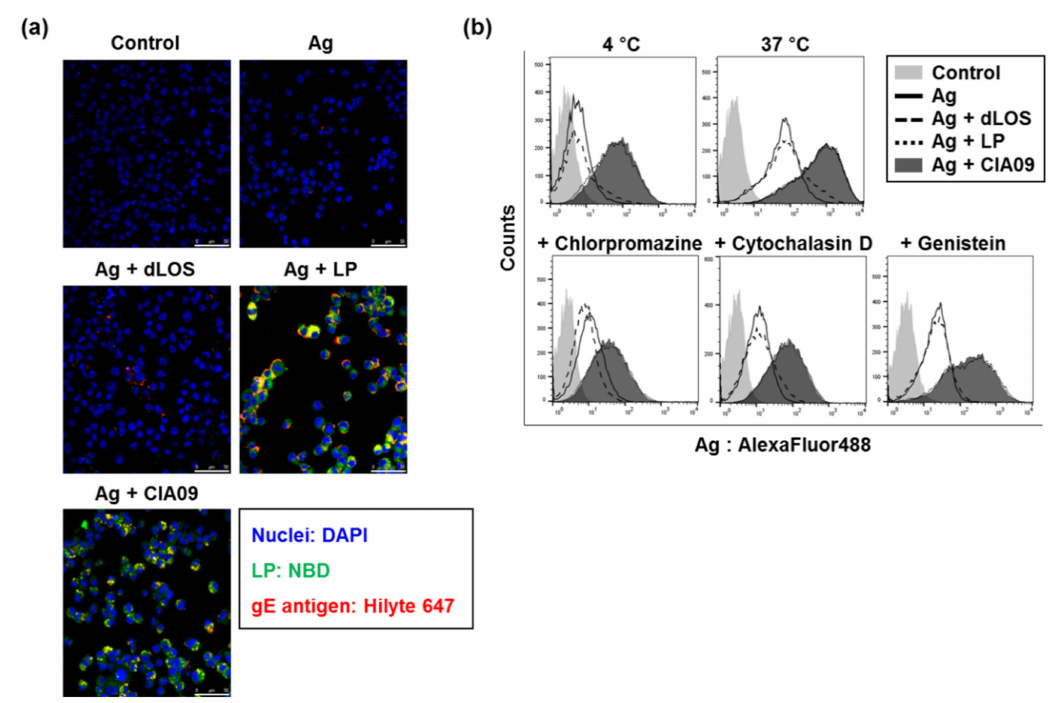
Figure 4. Liposome-mediated antigen uptake by DC2.4 cells. ( a ) Cells were incubated with Hilyte 647-labeled VZV gE antigen alone or gE plus dLOS (3 µ g/mL), NBD-labeled liposomes (LP) (100 µ g/mL), or both (CIA09) at 37 ◦ C for 4 h, stained with DAPI, and imaged by confocal microscopy. Scale bars = 50 µ m. ( b ) Cells were incubated with AF488-labeled gE antigen alone or gE plus dLOS (3 µ g/mL), liposomes (100 µ g/mL), or CIA09 at 4 ◦ C or 37 ◦ C for 2 h and analyzed by flow cytometry. Endocytosis inhibitors were added to the cells 1 h before sample treatment. The data presented are representative of at least three experiments with similar